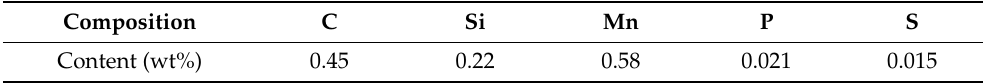
Table 1. Chemical composition of continuous casting slab of 45# medium carbon structural steel.